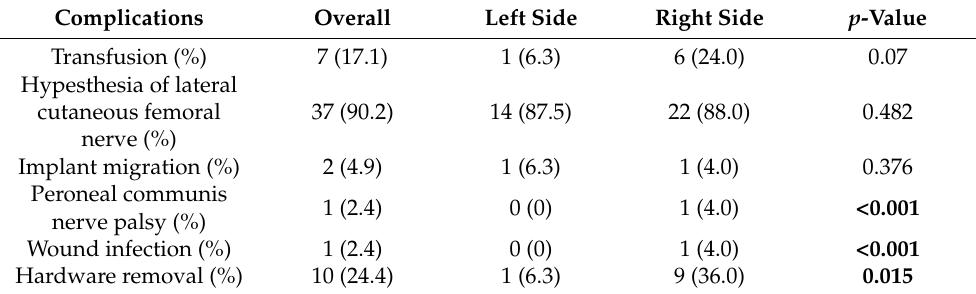
Table 5. Complication rate after periacetabular osteotomy. (Bold values denote statistical significance).